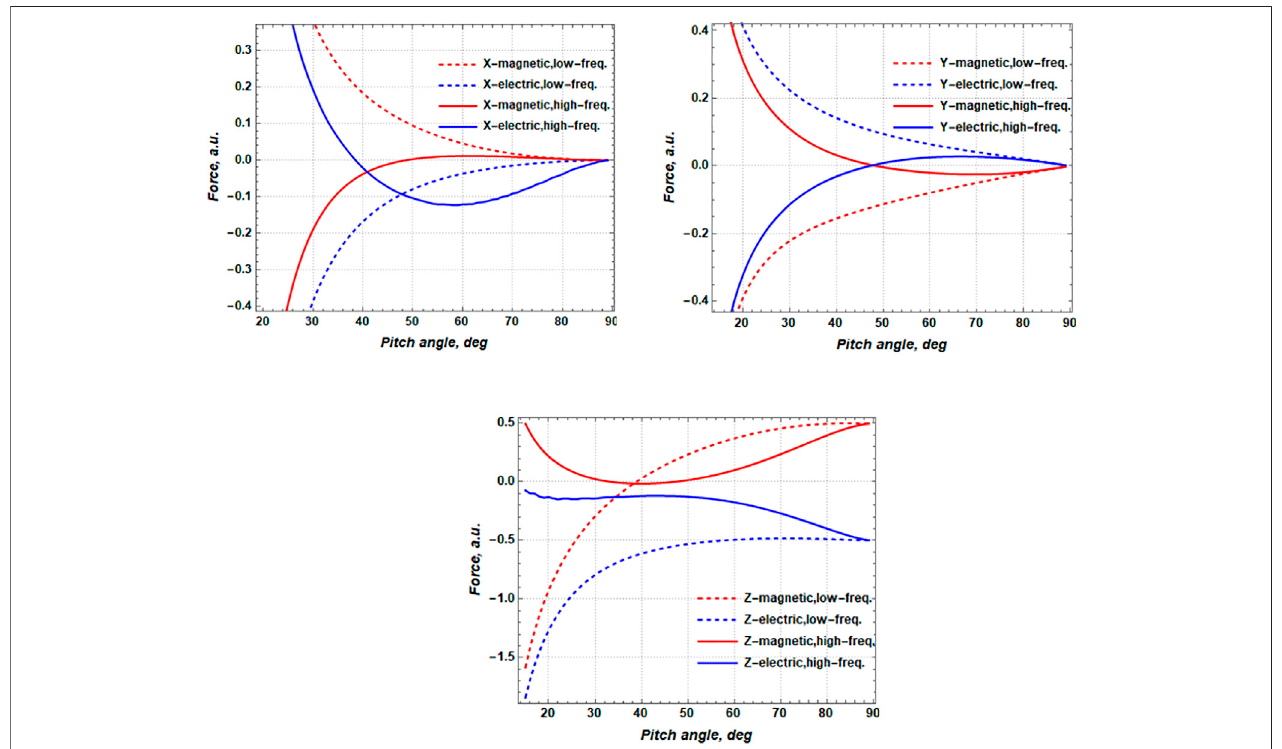
FIGURE 2 | X, Y, and Z-components of elementary forces vs. pitch angle calculated both for the low-frequency (dashed lines) and high-frequency (solid lines) cases. All the components of the forces are normalized to a factor Ω .